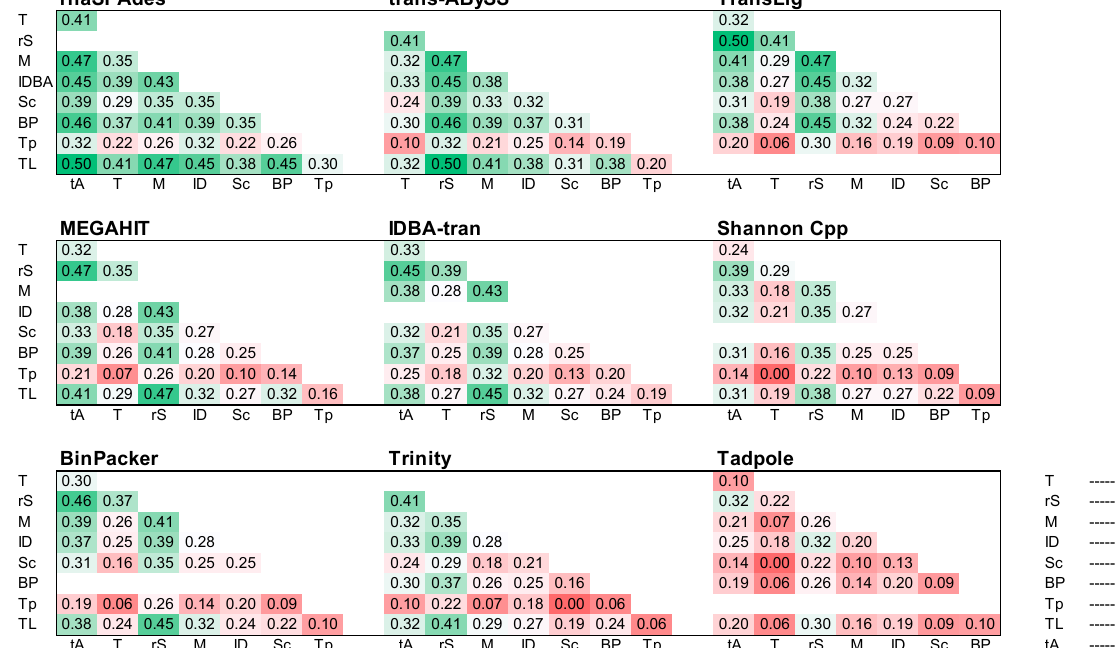
Figure 6. Tri-assembly score distributions. Violin plots representing assessment score frequency and distribution among tri-assembly runs. All assembler metrics are compared to over/underperfor- mance to the average MEGAHIT single-assembly score (0). All tri-assembly scores performed equal